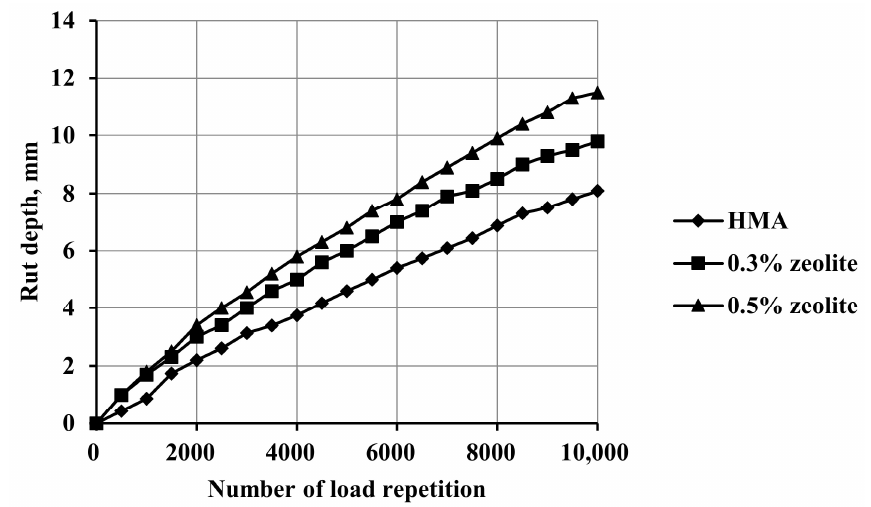
Figure 7. Rut depth result values at 40 °C.